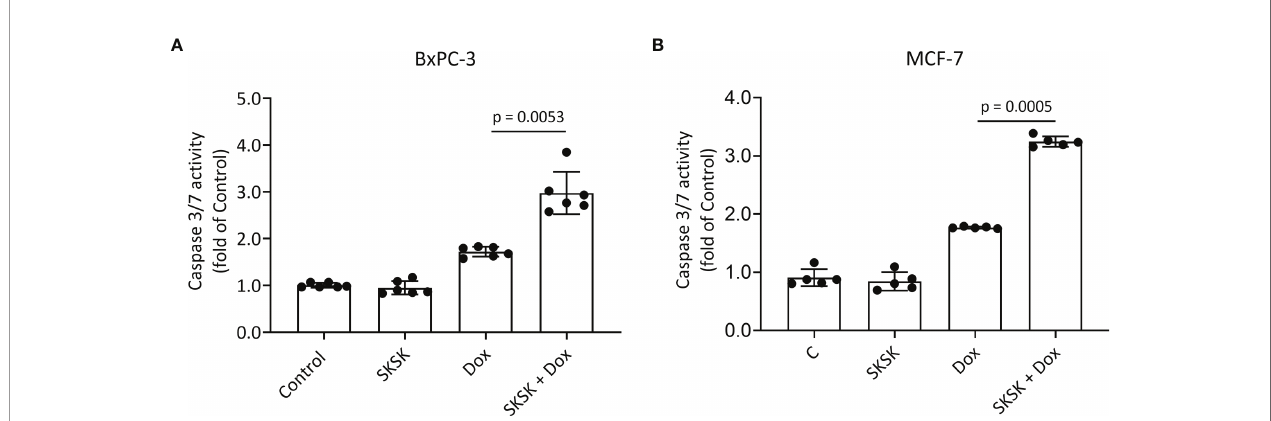
FIGURE 5 | Effect of FXYD3-pep SKSK on caspase 3/7 activity. (A) BxPC-3 and (B) MCF-7 cells were exposed to solutions that included 1 m M FXYD3-pep SKSK or were peptide-free for 24 h and then for a further 48 h to solutions that included the peptide or were peptide-free and included Dox, 0.5 m M for the BxPC-3 cells, and 2.5 m M for the MCF-7 cells as indicated. Caspase 3/7 activity was used as index of apoptosis. N = 5.